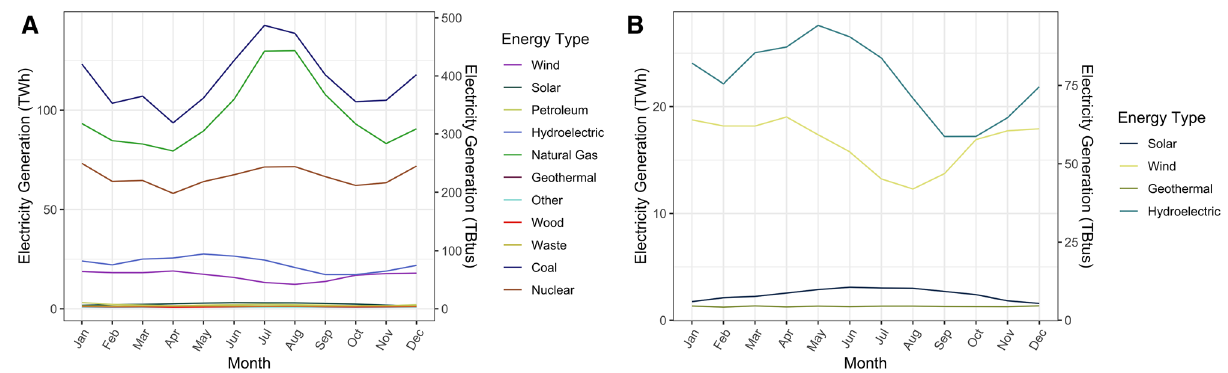
Figure 5. Monthly average electricity generation by source from March 2010 to February 2020. ( A ) Monthly average electricity generation by all sources. ( B ) Monthly average electricity generation by